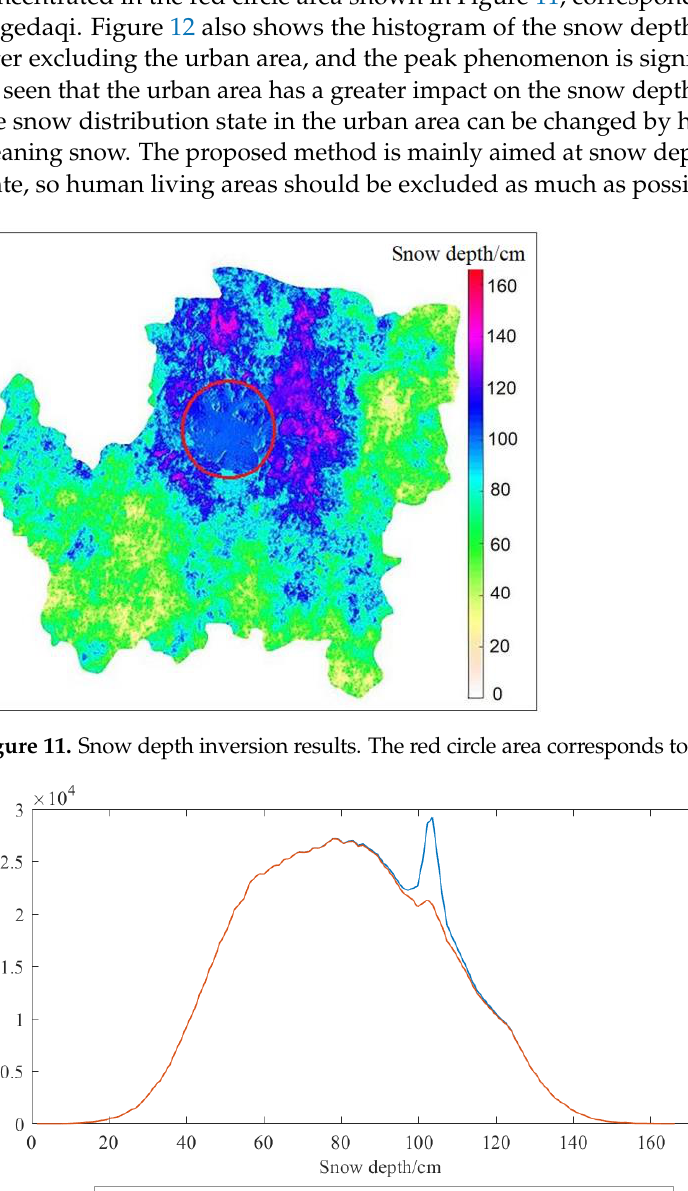
12 of 19 Figure 10. Snow phase after correction: ( a ) modified snow phase box-plot diagram, there is no ab- normal value in both non-forest and forest areas; ( b ) snow phase diagram. In this paper, the dry snow density ρ = 0.18 g/cm 3 is taken as the empirical value, the radar wavelength λ = 5.5466 cm, the local incident angle is used to replace the satel-